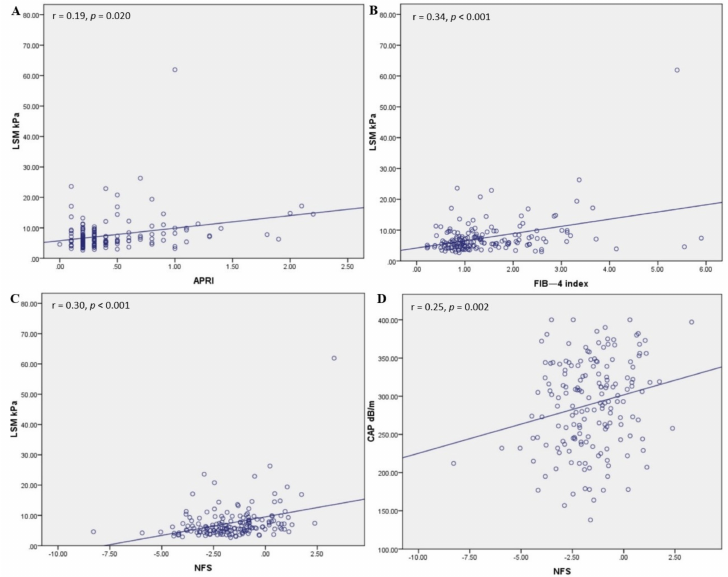
Figure 3. ( A ) Correlation between LSM and APRI, ( B ) FIB—4 index, and ( C ) NFS. ( D ) Correlation between CAP score and